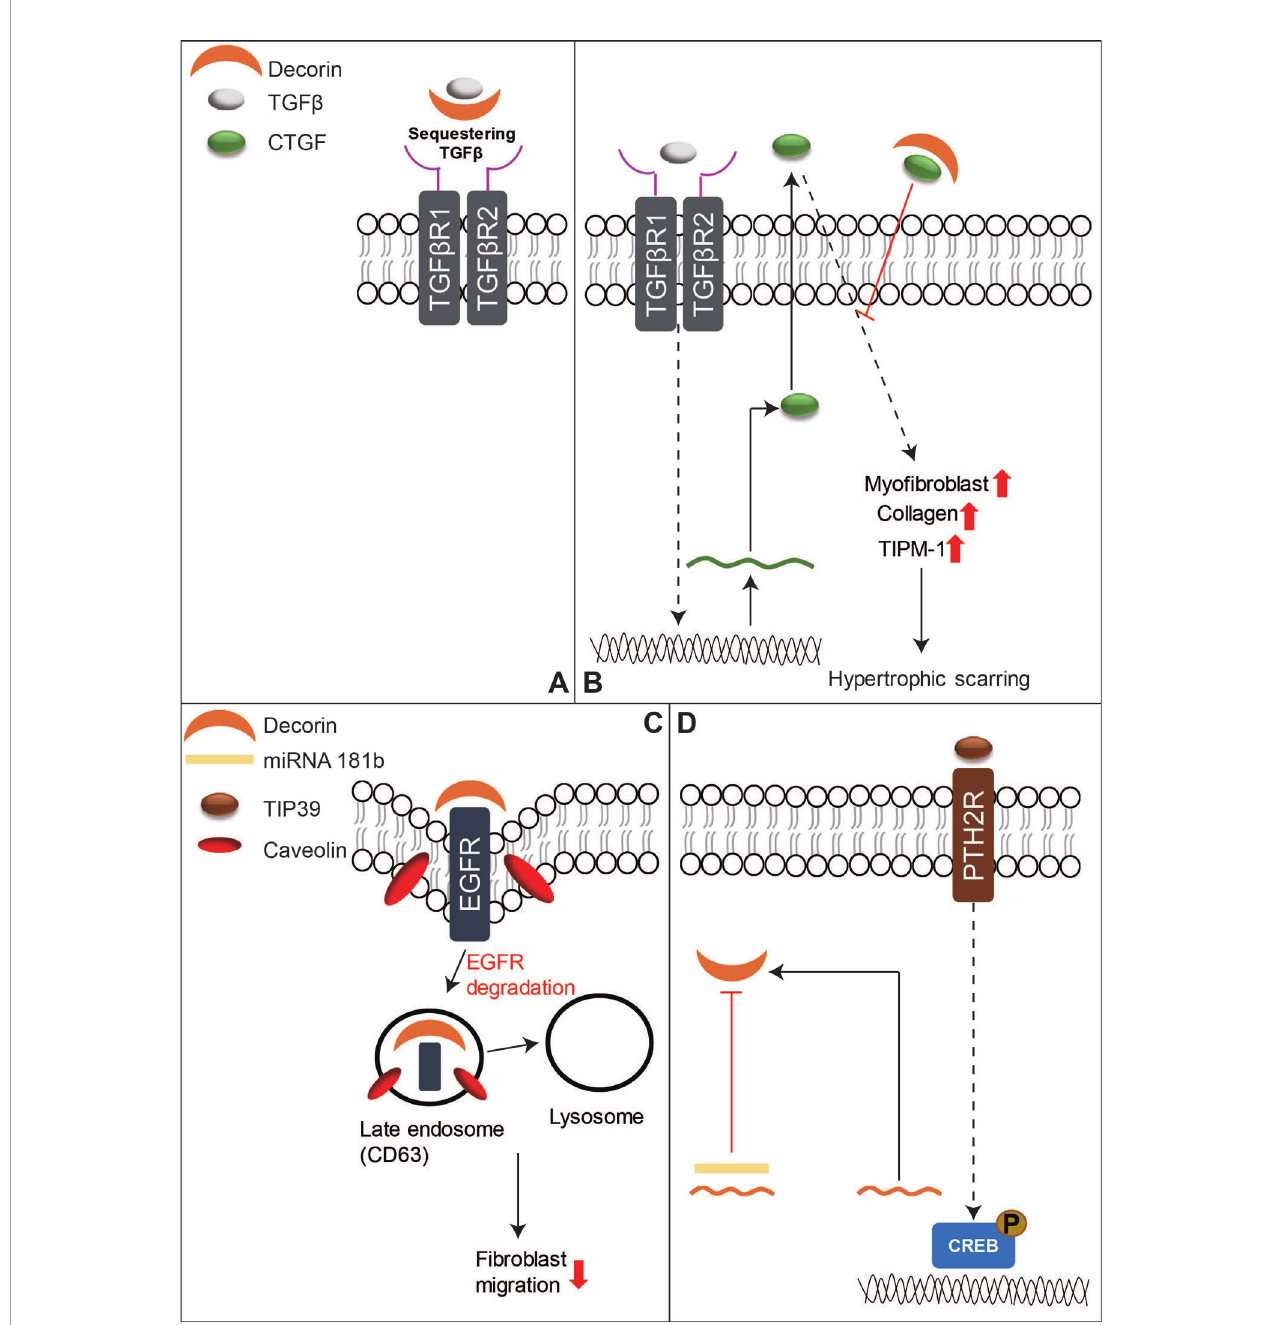
FIGURE 3 | A schematic diagram of the functions of DCN in skin wound healing. (A) DCN is known to bind to mammal TGF b isoforms to sequester their signal transduction. (B) DCN can also bind to CTGF, which is a downstream mediator of TGF b 1 signaling, to reduce hypertrophic scarring. (C) In addition, DCN can repress fi broblasts migration by inducing EGFR degradation. (D) On the other hand, activation of TIP39-PTH2R signaling or blocking of microRNA 181b can induce DCN production, and thus bene fi t skin wound